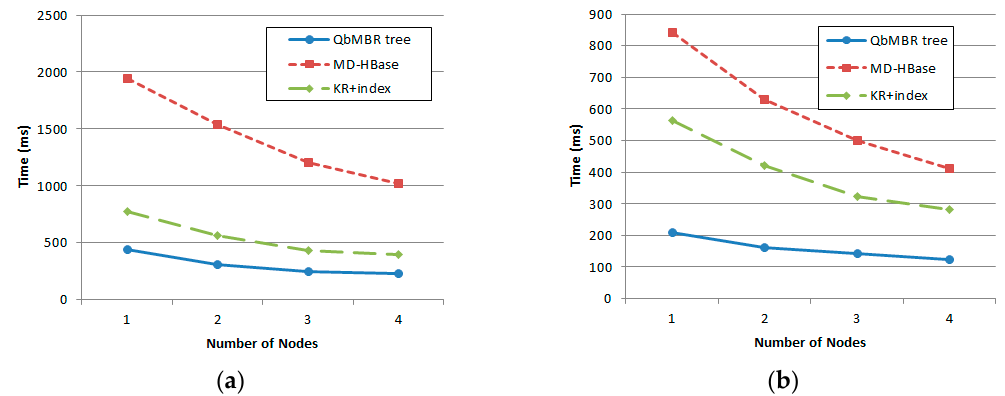
Figure 15. Effect of cluster size on response time: ( a ) Response time of range query; ( b ) Response time of kNN query.